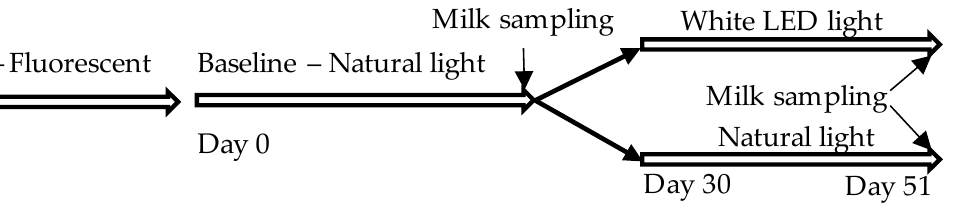
Figure 1. The experimental timeline and sampling. Table 1. Illumination conditions and selected parameters collected at the end of the experimental phases. The data are presented as mean ± SD.